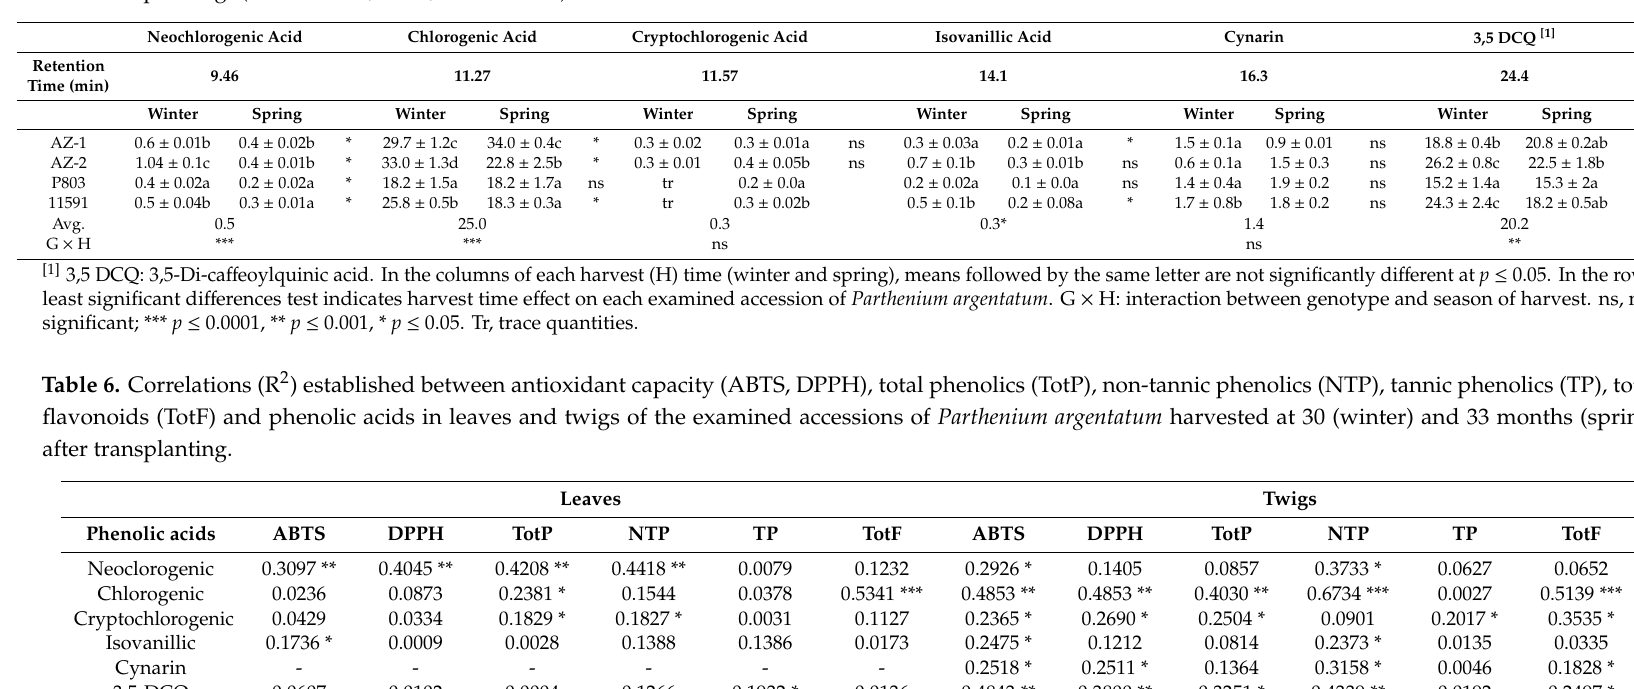
Table 5. HPLC analysis of phenolic acids (mg g − 1 DM) in twigs of the examined accessions of Parthenium argentatum harvested at 30 (winter) or 33 months (spring) after transplanting. (Means ± SD, n = 3, Fisher’s test).